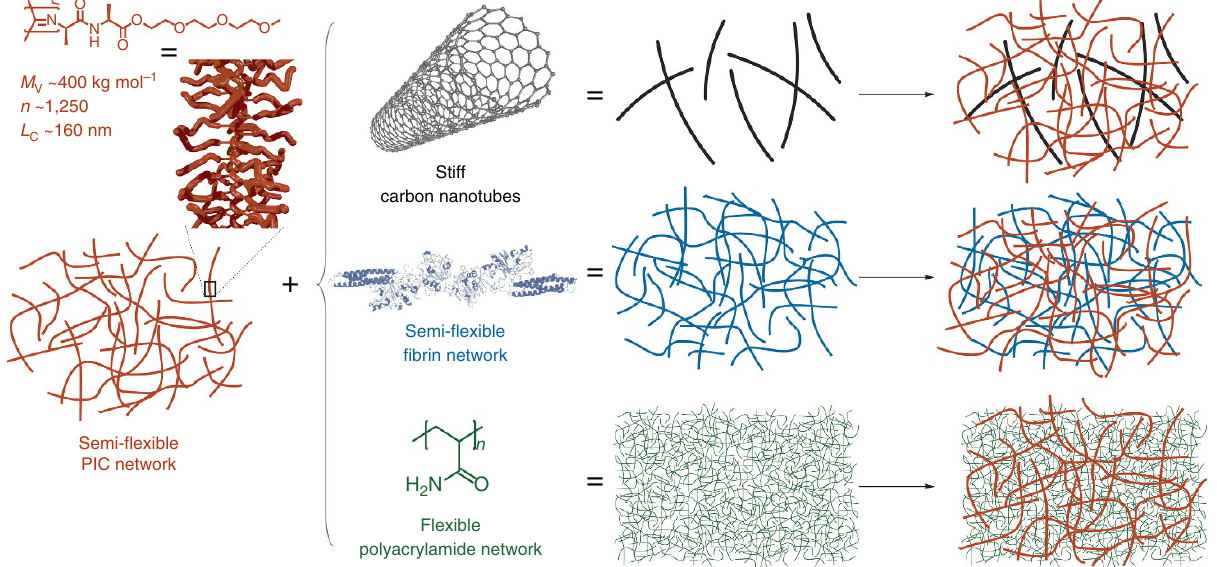
Figure 1 | Composite hydrogel components. The primary component of each hydrogel is a network of semi-flexible ethylene glycol-functionalized PICs (shown in red), which are long polymers trapped in a relatively stiff helical conformation. Heating an aqueous PIC solution above its gelation temperature induces bundling and gel formation. The second component of the hybrid hydrogels used are stiff CNTs (black), a network of semi-flexible fibrin fibres (blue) or a network of flexible PAAm polymers (green). The CNTs become interlocked in the PIC network on gelation, because their length is many times the PIC gel pore size. The other two hybrid gels are formed by polymerization of either fibrinogen or AAm monomers in the presence of a pre-formed PIC network. The double-network composites can be only mechanically interlocked (interpenetrating networks) or conjugated